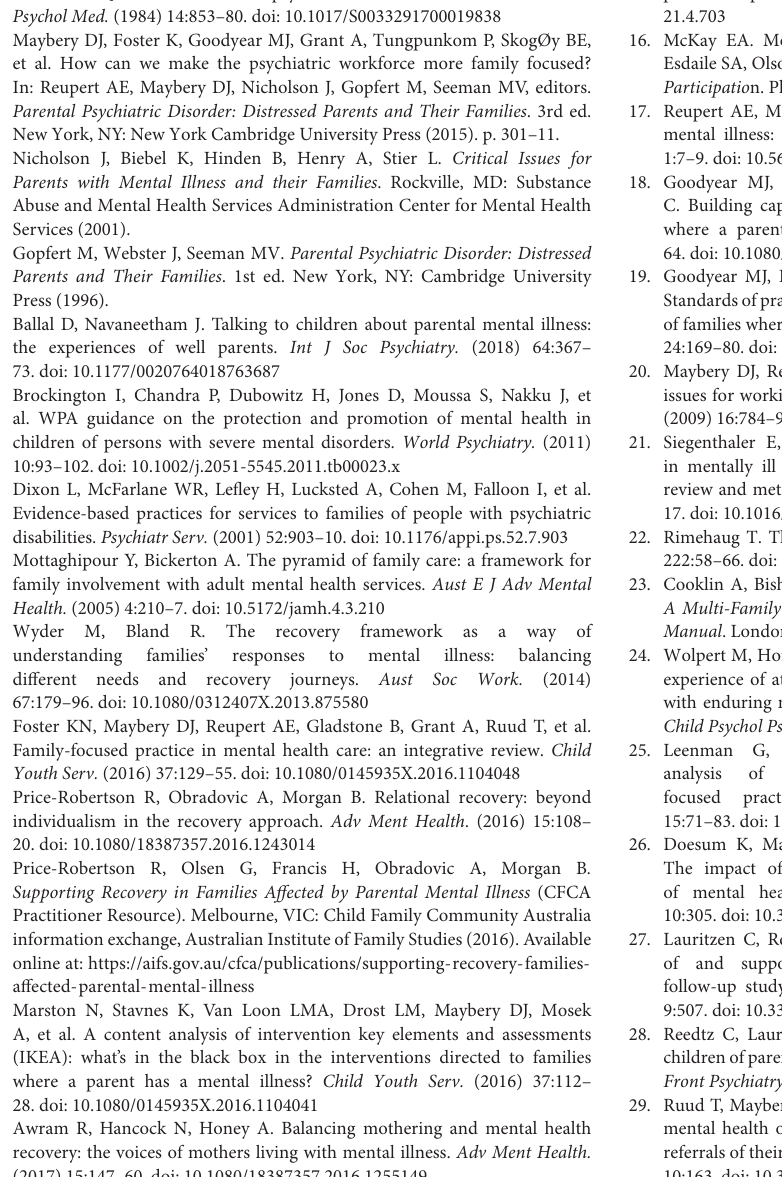
referrals of their children, and patient characteristics. Front Psychiatry. (2019) 10:163. doi: